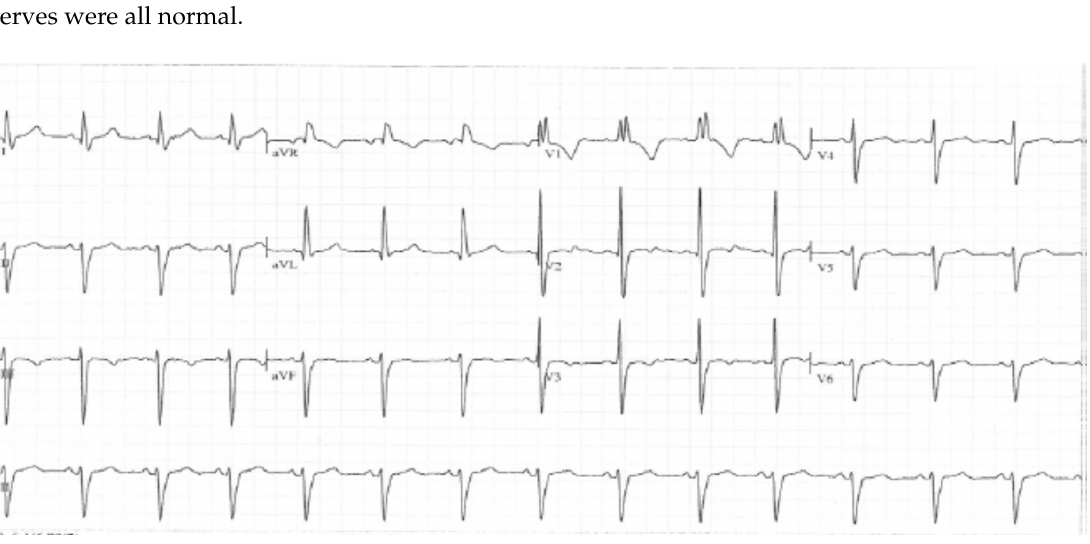
Figure 1. Electrocardiogram of the patient, which shows normal findings for a child of her age. Brain MRIs showed discrete asymmetry of the lateral ventricles (the right side was larger) and discrete bifrontal subdural hygroma (Figure 2).